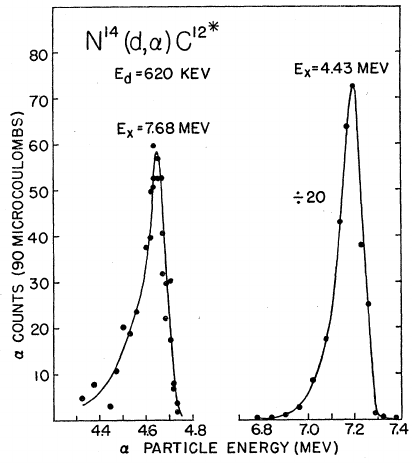
Figure 8.15: Dunbar’s et al. 1953 result. A beau- tiful manifestation of the predicted 7 . 68MeV level. Figure 10: The structure of 12 C after Dunbar et al discovery.